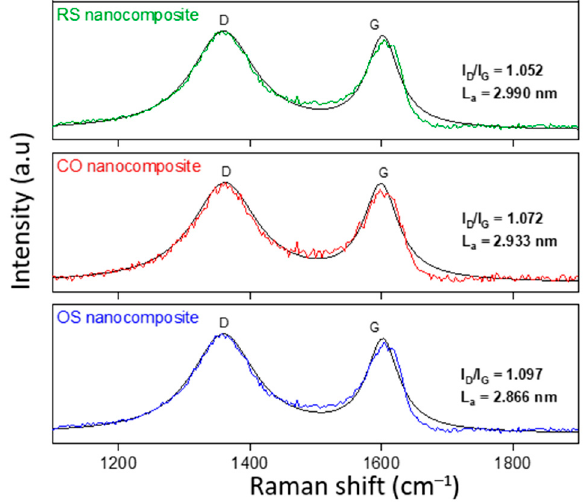
Figure 4. Raman spectra of OS, CO, and RS nanocomposite.